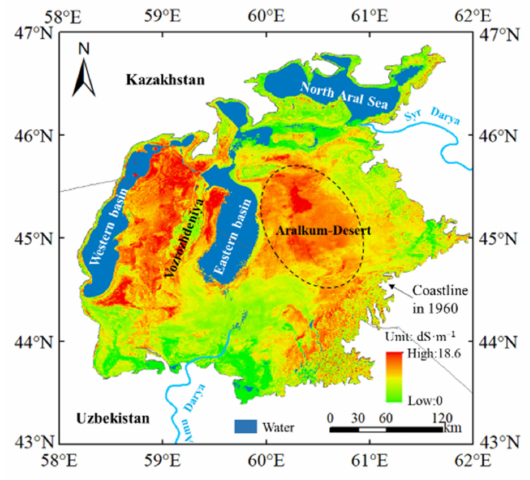
Figure 6. The distribution of soil salinity on the exposed seabed during 2016–2020.